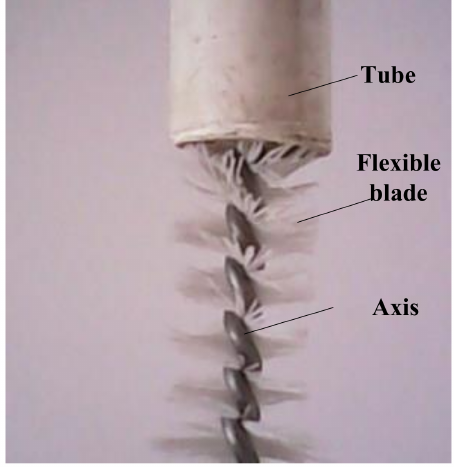
Figure 14. Flexible blade